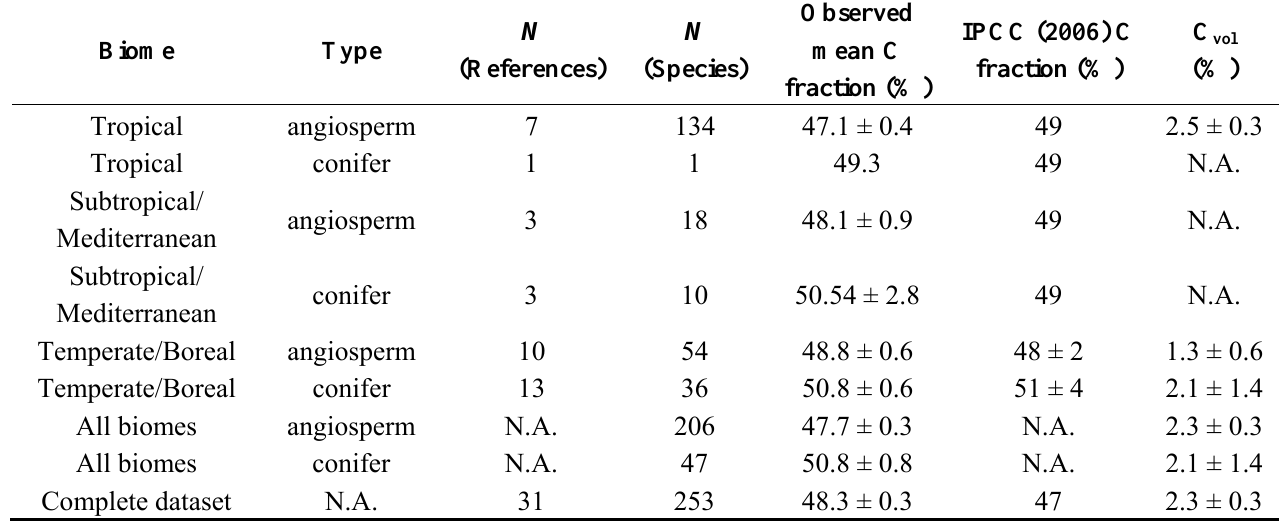
Table 2. Summary data for mean stem wood C and mean volatile C fraction (C for angiosperms and conifers, from three provenances. Error terms represent 95% confidence